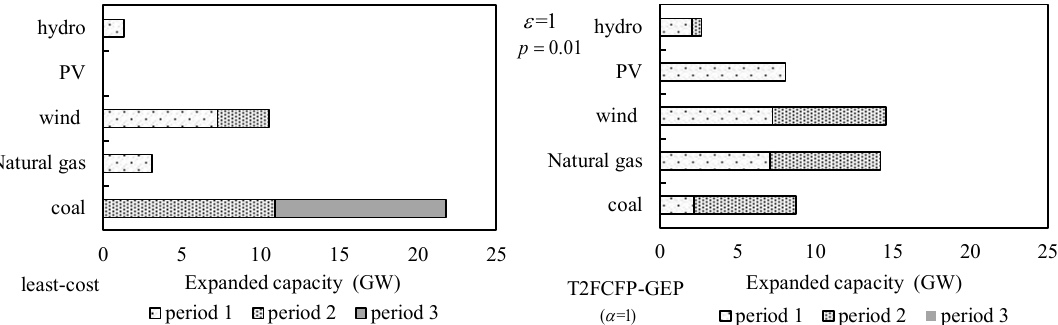
Figure 11. Comparison of power generation patterns from T2FCFP-GEP and least-cost models.